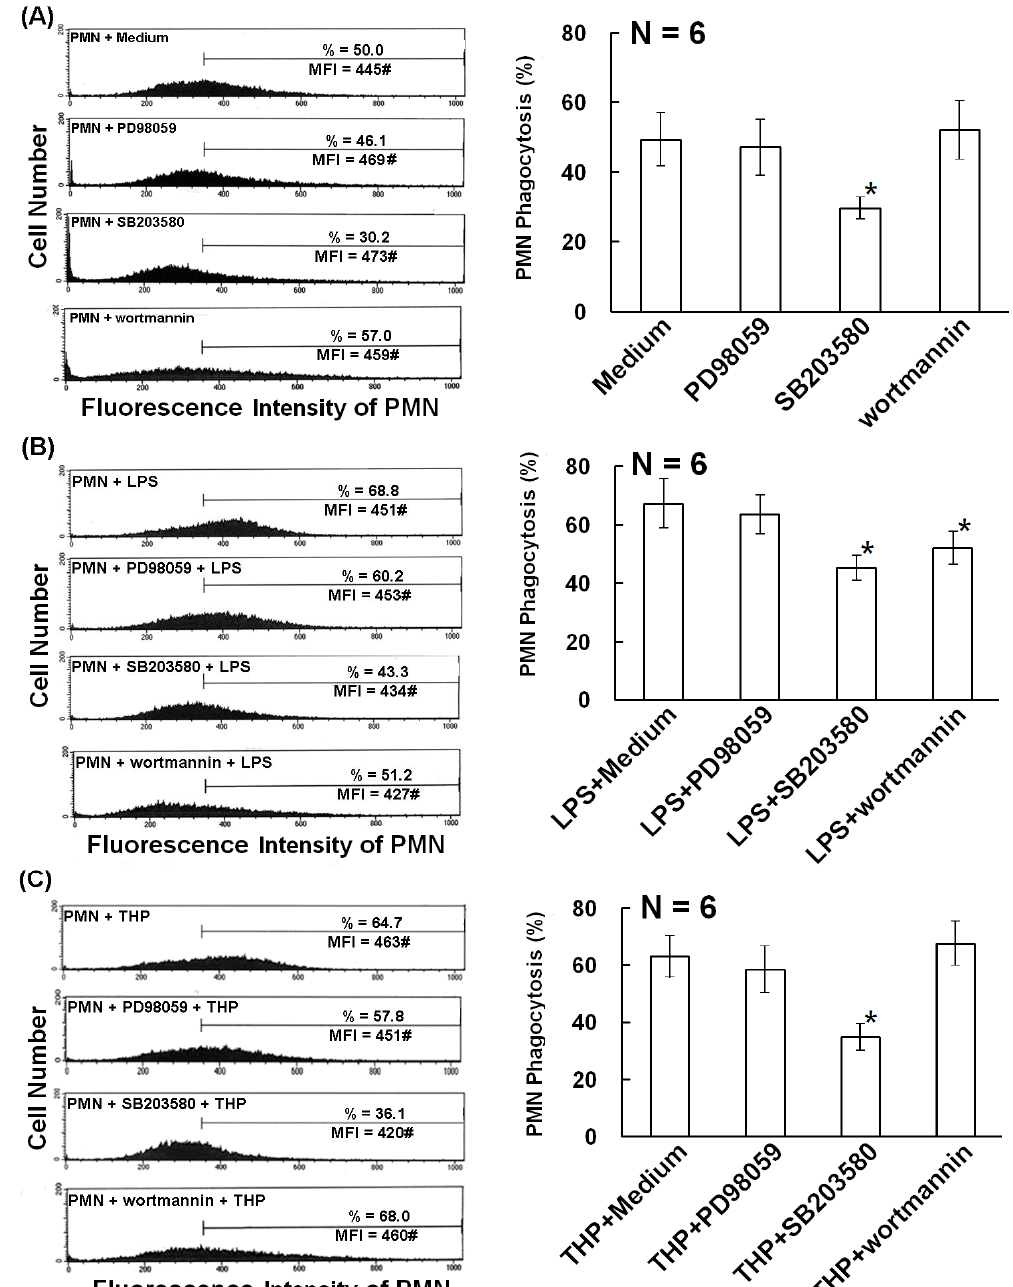
Figure 2. Effects of different protein kinase inhibitors on spontaneous, LPS (20 ng/mL)-, and THP (10 μ g/mL)-induced phagocytosis. ( A )–( C ): The left panel shows a representative case and the right panel shows statistical assessment. ( A ) Spontaneous PMN phagocytosis was detected after pretreatment with different protein kinase inhibitors including PD98059 (50 μ M, a non-competitive inhibitor of MAPK kinase 1), SB203580 (1 μ M, a p38 inhibitor), or wortmannin (0.1 μ M, a specific covalent inhibitor of PI3K). ( B ) LPS-stimulated PMN phagocytosis was detected after pretreatment with different protein kinase inhibitors as demonstrated in ( A ). ( C ) THP-stimulated PMN phagocytosis was measured after pretreatment with different protein kinase inhibitors as above. * denotes p ≤ 0.05 compared to medium